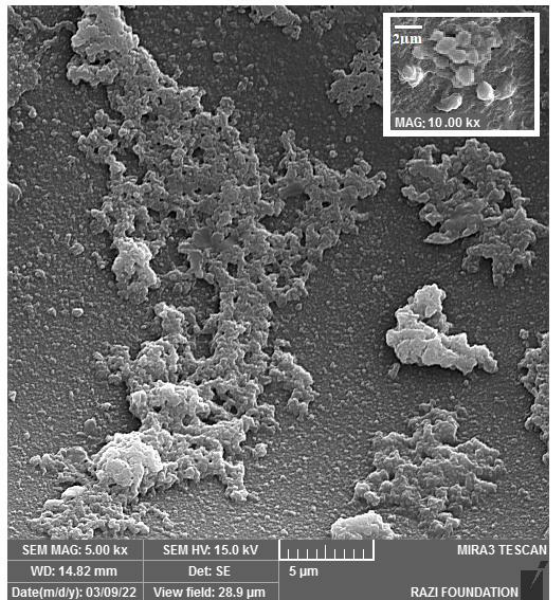
Figure 10. The absorption and aggregation of platelets on the produced